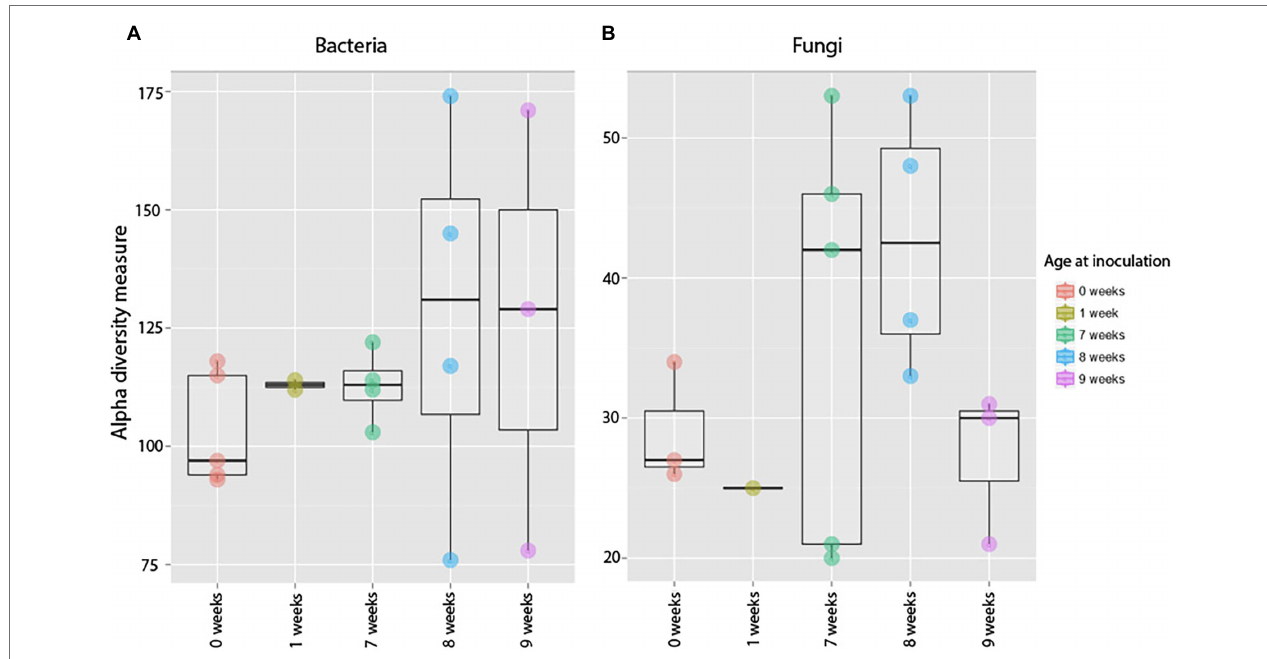
FIGURE 6 | Alpha diversity measures of bacterial (A) and fungal (B) communities in 12-week-old roots that were exposed to soil at different developmental stages. Each dot represents a sample, and the variation among samples is calculated using observed Operational Taxonomic Unit (OTU) richness. Timing of exposure had